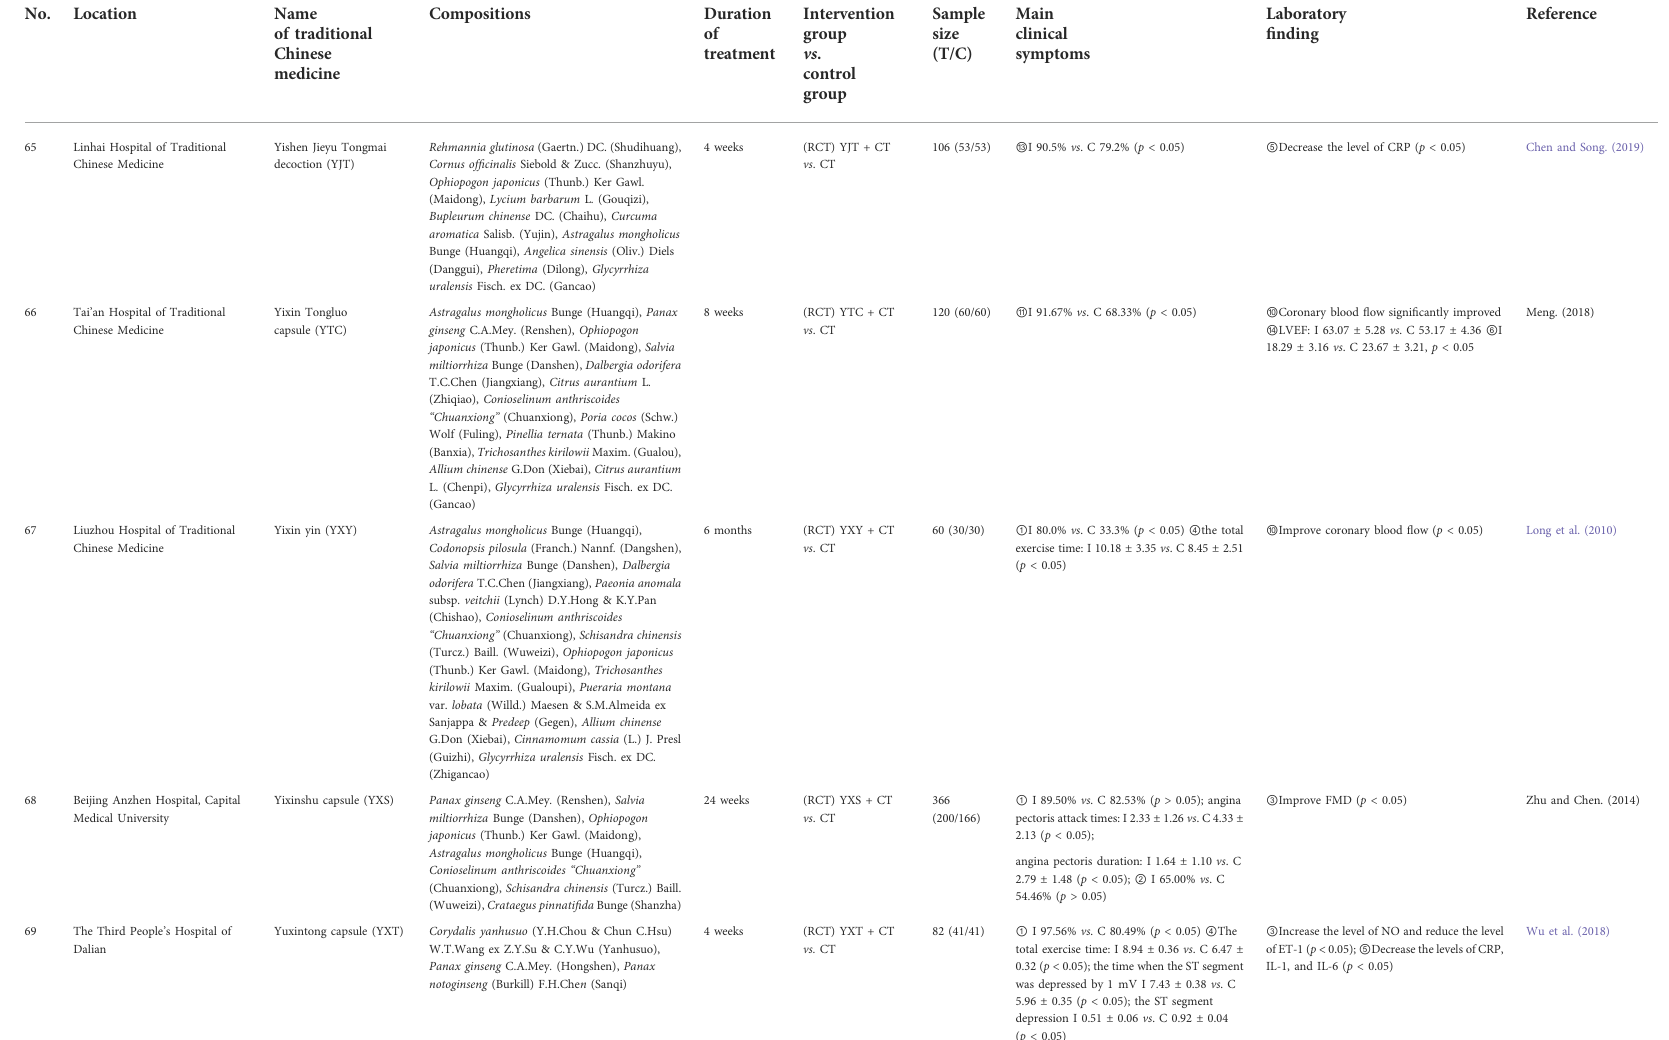
TABLE 1 ( Continued ) Clinical evidence of TCM for